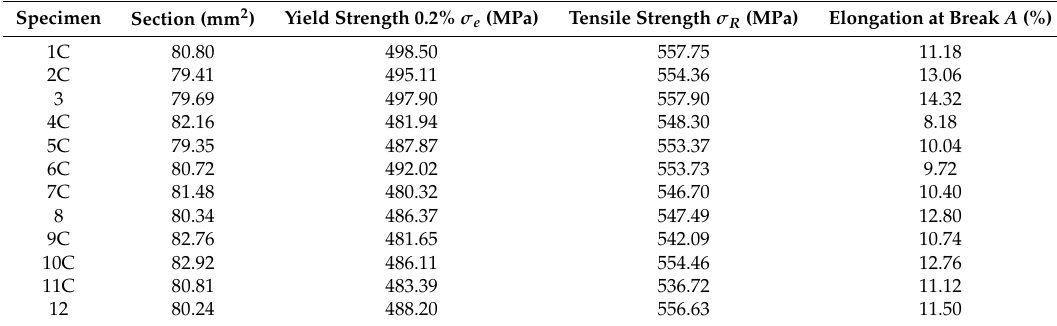
Table 3. Testing and measurement results.